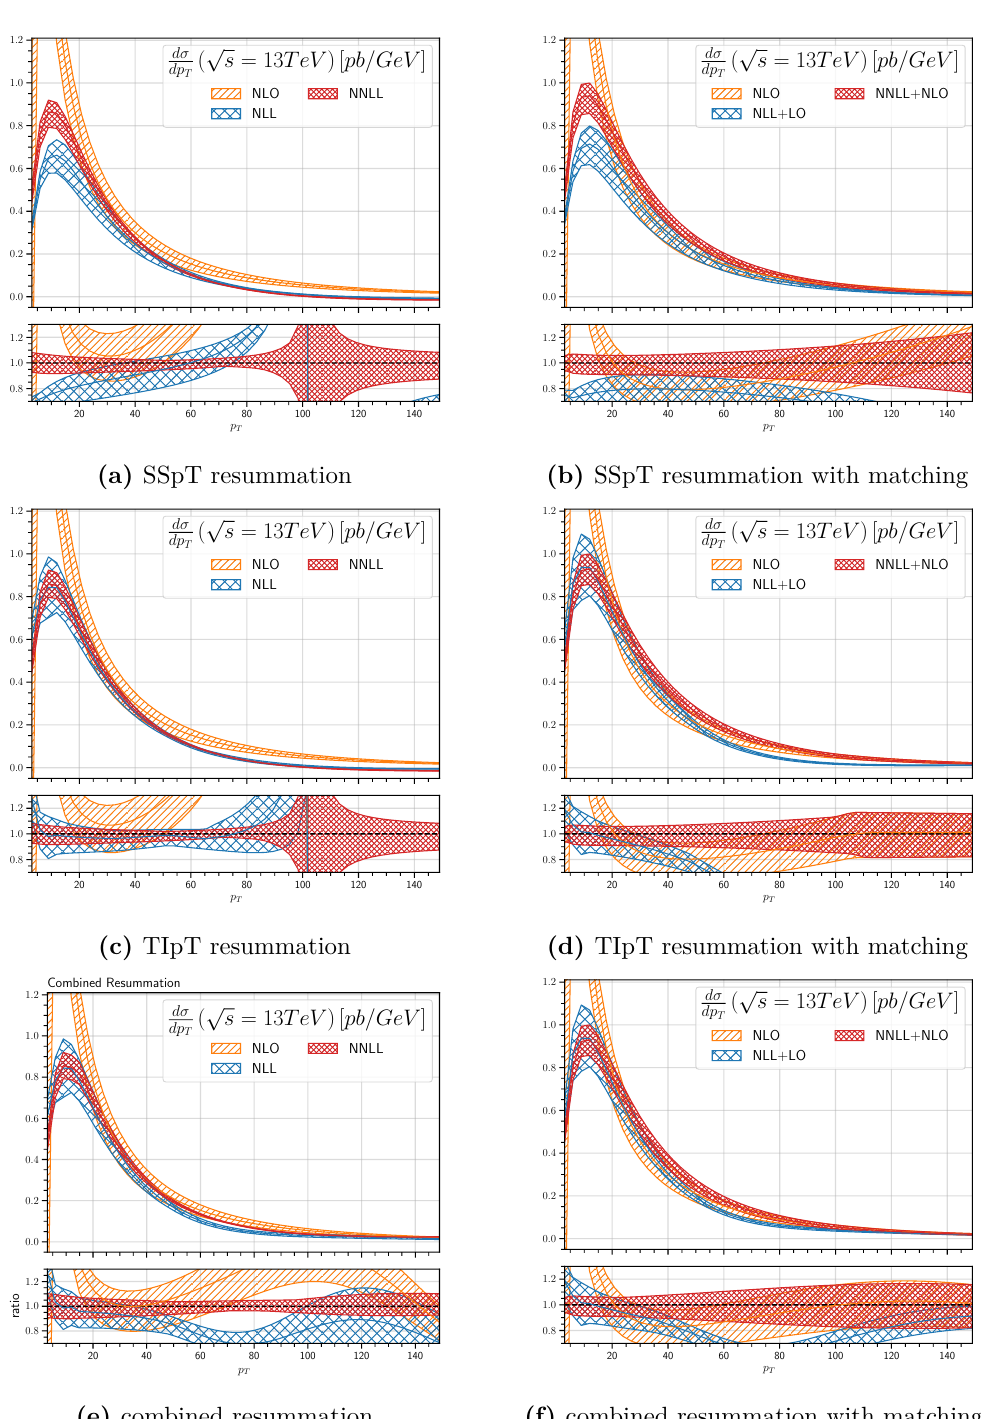
Figure 5. p T spectrum of the Higgs boson production for various types of resummation: standard small- p T ( top ), threshold-improved small- p T ( middle ), and combined ( bottom ). The left plots show the pure resummation results while those matched to the fixed-order are shown on the right . The top panels compare the NLL and NNLL resummed results with the NLO. The lower panels show the ratio w.r.t. to the central value of the respective NNLL results. The uncertainty bands are computed by varying µ R and µ F using the 7-point method; in all cases, Q = m H